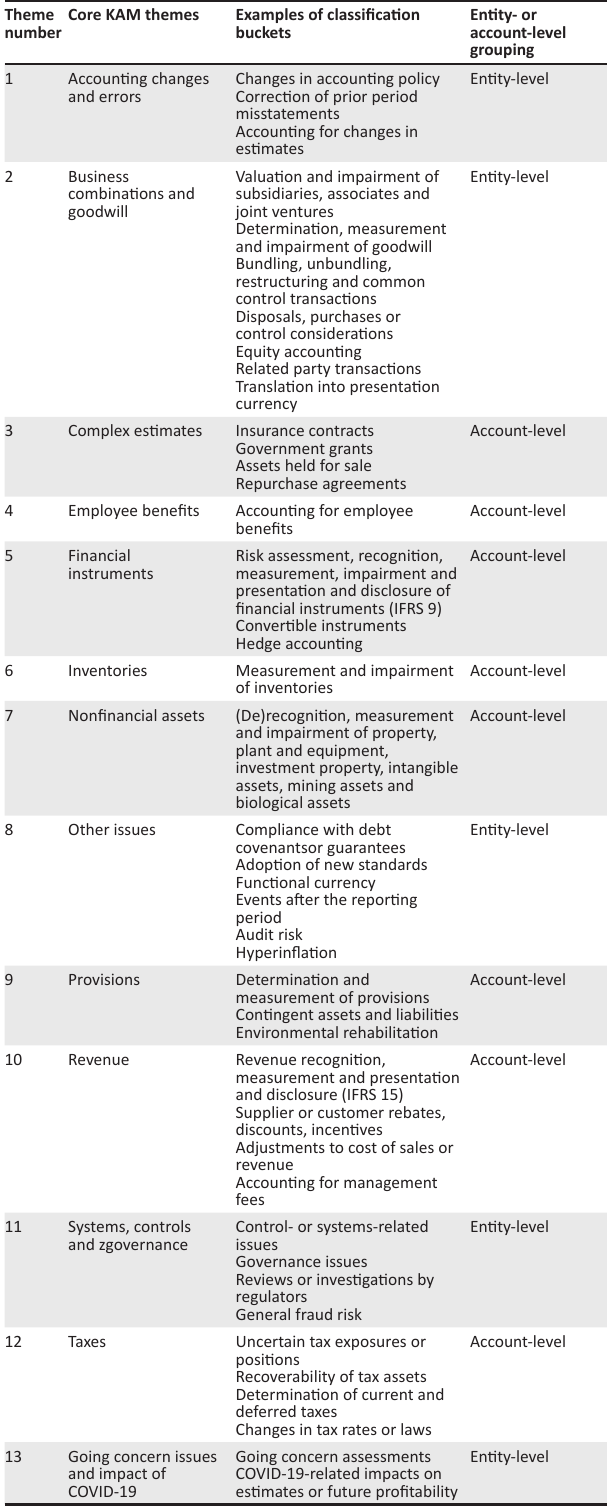
TABLE 1: Core key audit matter themes and examples of key audit matter detail classification